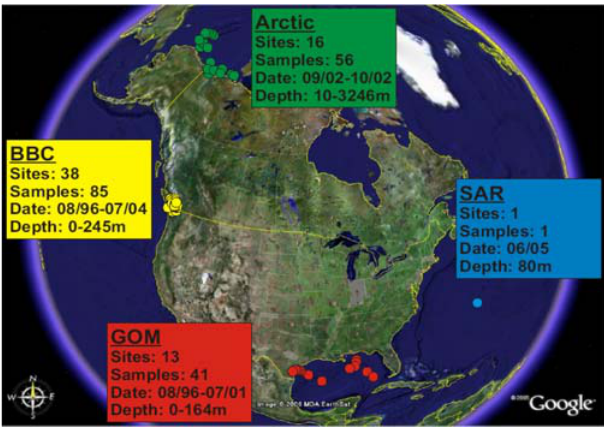
Figure 1. Sampling Sites The circles represent the sampling locations in the Sargasso Sea (SAR), Gulf of Mexico (GOM), British Columbia (BBC), and the Arctic Ocean. The number of samples taken at each location and combined for sequencing, as well as the date and depth range, are shown in the boxes. DOI: